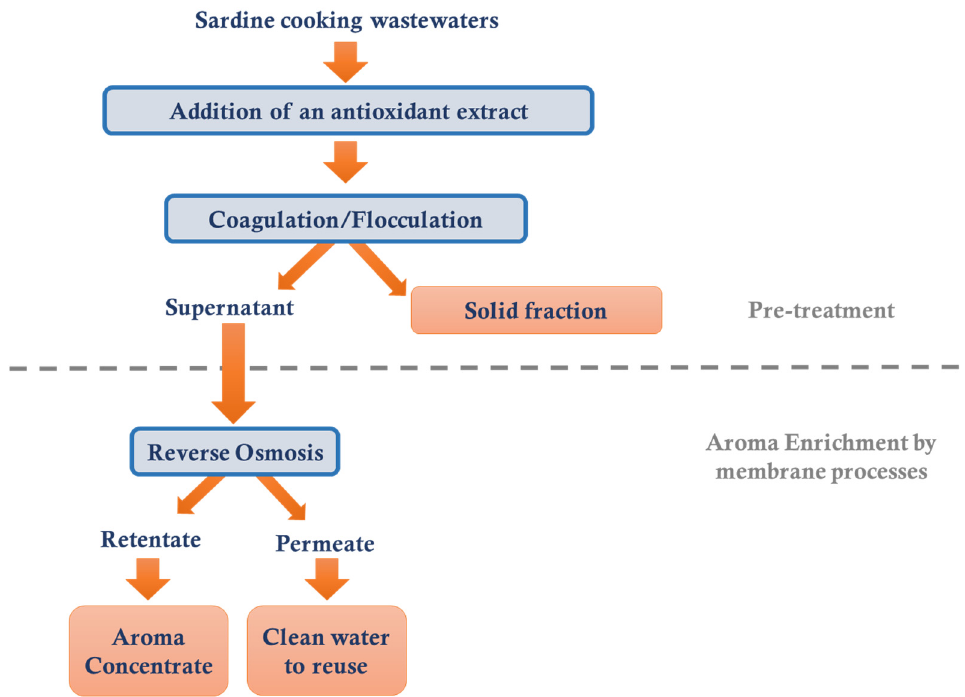
Figure 1. Flow diagram summarising the experimental studies performed in this work.